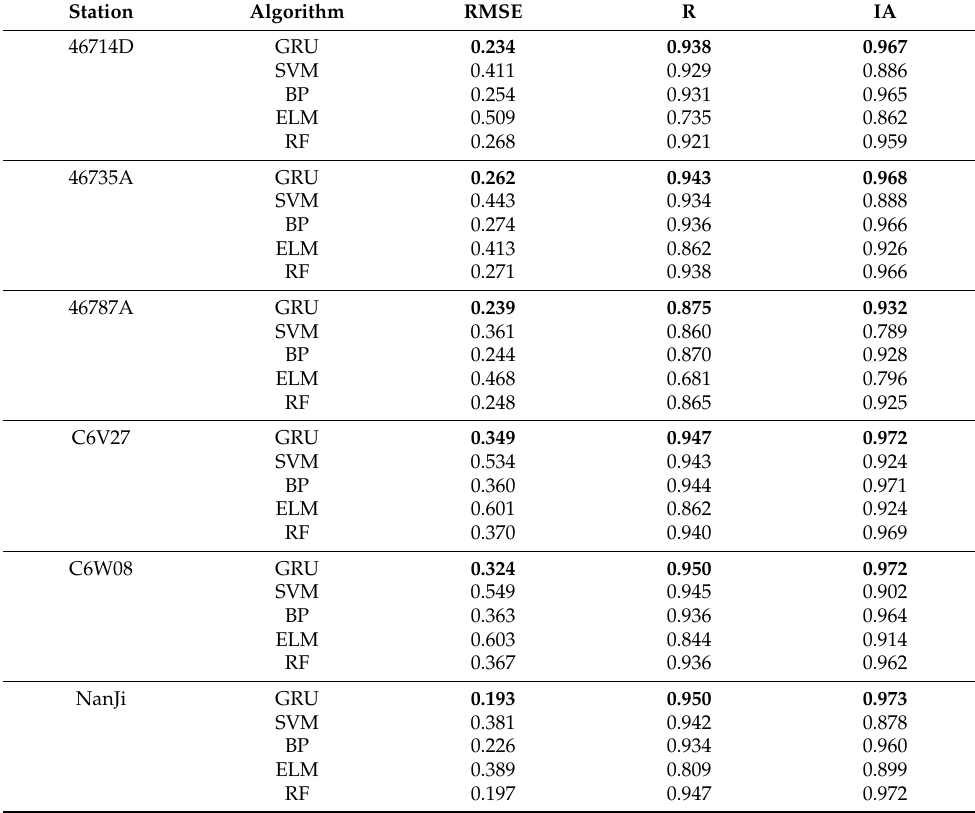
Table 3. Error indices of predicted SWH with lead times of 3